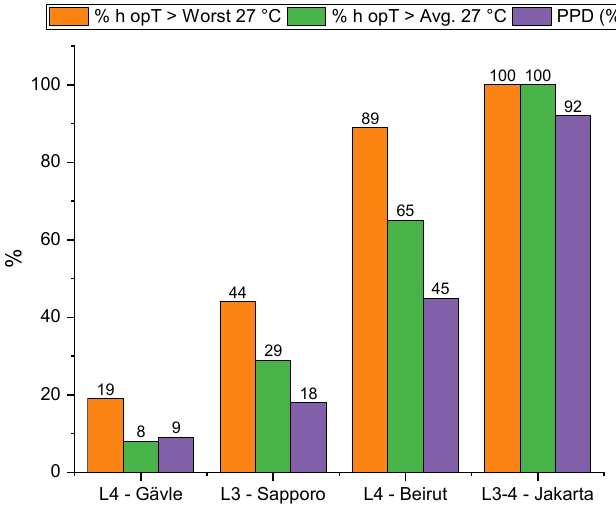
Figure 20. Best possible thermal comfort configuration for each location.